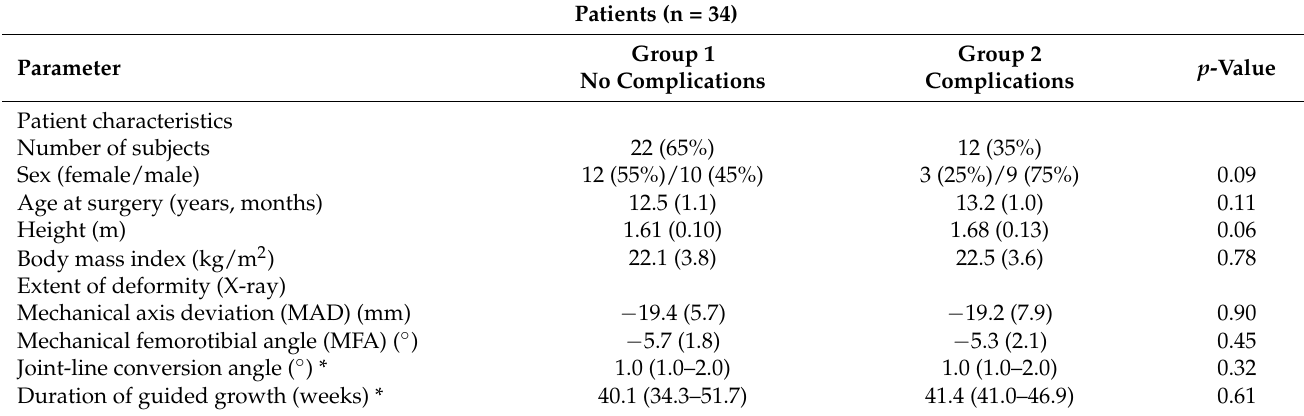
Table 1. Group differences.